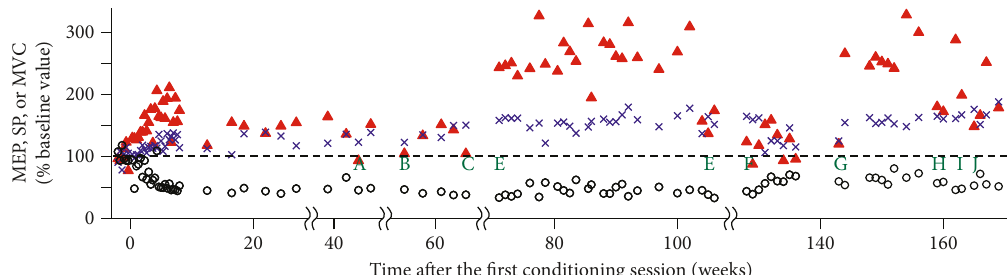
Figure 3: TA MEP ( fi lled triangle), MVC (cross), and SP (circle) over 3.3 years of study including baseline to conditioning to follow-up periods in subject A. During the follow-up period (i.e., after 8 weeks of conditioning), her o ffi cial diagnosis changed (from secondary progressive MS to relapsing-remitting MS) and so did her medication. Notable events in her life and neurological/medical history during the study period are indicated as A – J. (A) A few days after the fi rst rituximab injection. (B) Feeling tired due to personal life issue. (C) Going through divorce. (D) Cortical mapping had been redone. TMS location was changed from “ 2.5cm lateral and 1.5cm anterior to the vertex ” . (E) Kidney infection. (F) MS relapse diagnosed; started taking dimethyl fumarate (tec fi dera); her gait had worsened. No visible ankle dorsi fl exion. ( ∗ Visible dorsi fl exion returned several weeks later.) (G) Frequent urinary tract infection for the past several weeks. (H) Started taking ropinirole hydrochloride (requip). Also started on tamsulosin and oxybutynin for UTI treatment/prevention. (I) Her mother just had a stroke. (J) Started taking interferon beta Ia (avonex). Throughout this lengthy follow-up and many life events, the MEP and MVC increases and the SP decrease associated with MEP up-conditioning